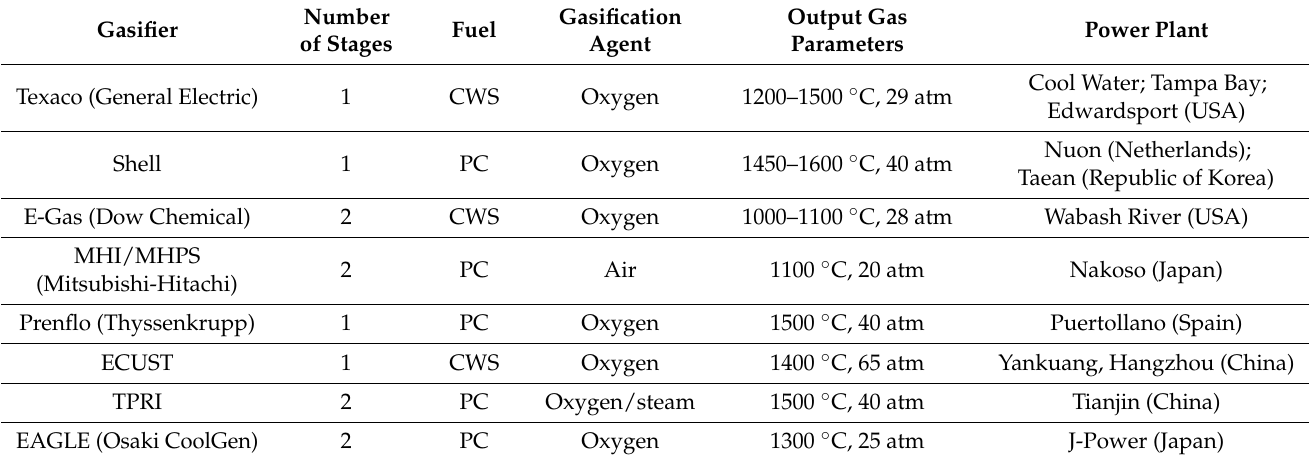
Table 1. Industrial entrained flow gasification processes (CWS—coal-water slurry; PC—pulverized